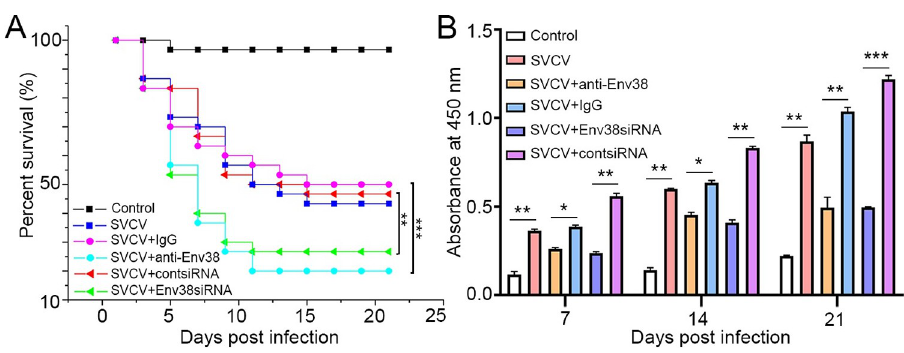
Fig 6. Evaluation on the functional role of Env38 in host antiviral immune defense and IgM antibody production. (A) Survival rate was calculated in anti-Env38 Ab-mediated blockade and Env38siRNA-LV-mediated knockdown treatment in zebrafish injected with SVCV (10 5 TCID 50 ) in continuous 21 days. Kaplan-Meier survival curves represented data pooled from three independent experiments. Statistical differences were analyzed by log-rank test. 30 zebrafish were used in each experiment (n = 30). (B) ELISA for kinetic production analysis of the anti-SVCV antibody (IgM) in serum of zebrafish with treatments of Ab-mediated blockade and siRNA-mediated knockdown of Env38 under challenge of SVCV (10 5 TCID 50 ) after 7, 14 and 21 days. Error bars represented SEM. Isotype IgG-treated groups and scrambled siRNA-LV treated groups served as nonrelated control groups (n = 30). Negative control groups received PBS treatment. Error bars represented SEM. ( � p < 0.05; �� p < 0.01; ��� p < 0.001; ns, no significant